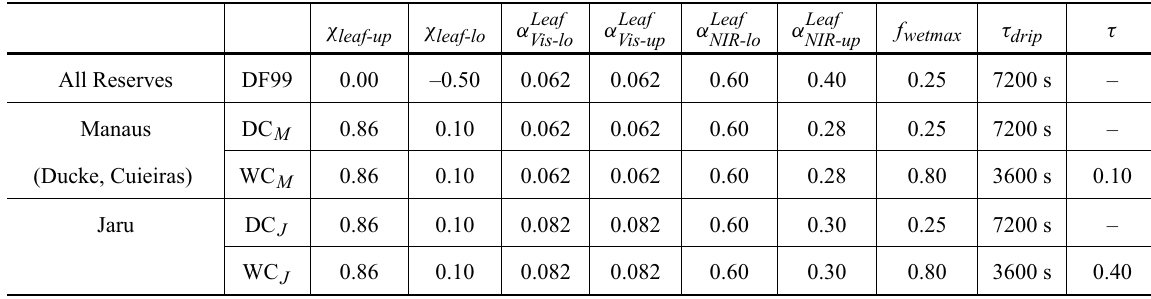
Optical parameters used by the DF99 calibration and new calibrations using the dry-canopy (DC i ) and wet-canopy (WC i ) versions of the model, where i is equal to M for the Manaus-nearby sites (Ducke and Cueiras Reserves) or J for the Jaru Reserve. χ leaf-lo and χ leaf-up are the upper and lower canopy leaf orientations, α and upper visible leaf reflectances of canopy, α f wetmax is maximum fraction of water cover on two-sided leaf, τ drip is the decay time for intercepted liquid drip off, and ν is the ratio of the scattering coefficients of the canopy surfaces wet by water and dry canopy surfaces individually applied to leaves and stems. All values are dimensionless, except for τ drip , which is in seconds.